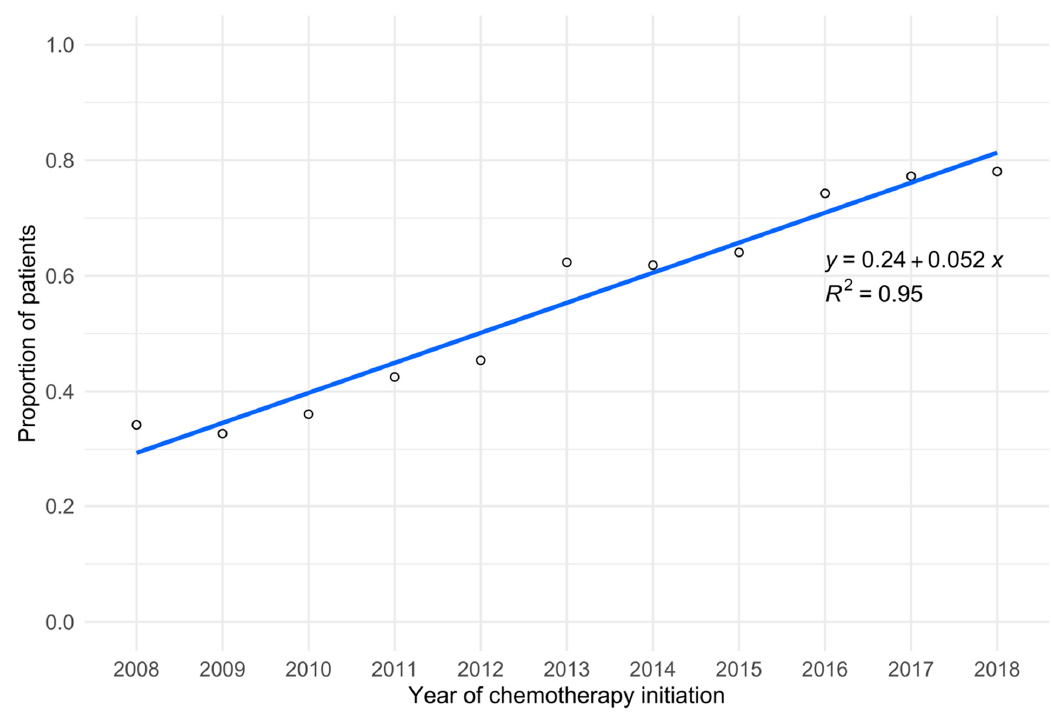
Figure 1. Trends in G-CSF usage by calendar year.